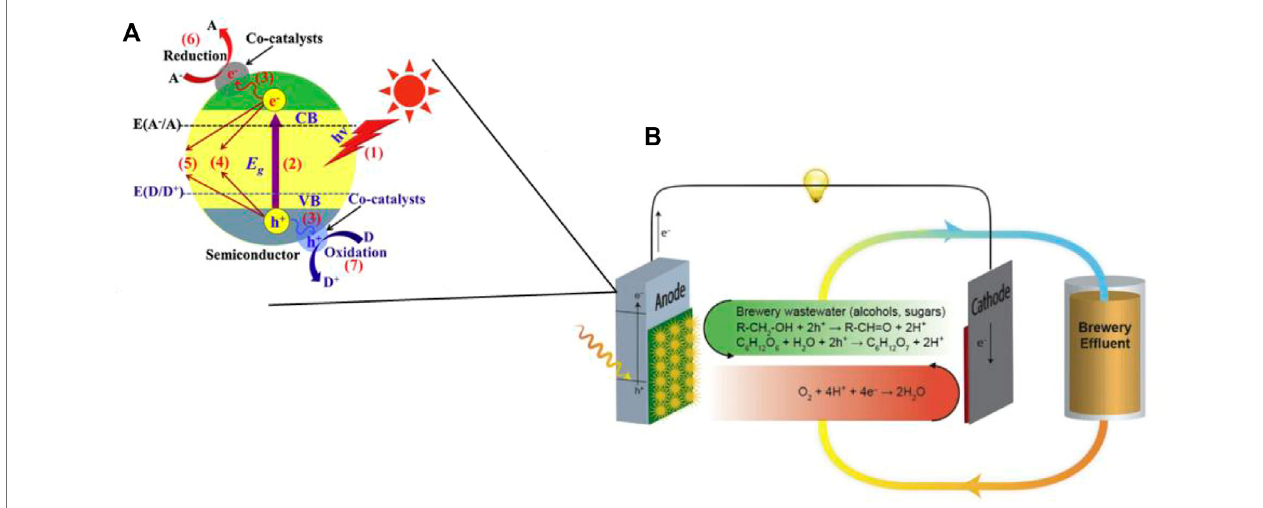
FIGURE1|(A) Basicprincipleofsemiconductorcathodephotocatalysis(Wenetal.,2017); (B) Schematicdiagramofphotocatalyticmicrobialfuelcellprinciple(Lui et al., 2019).